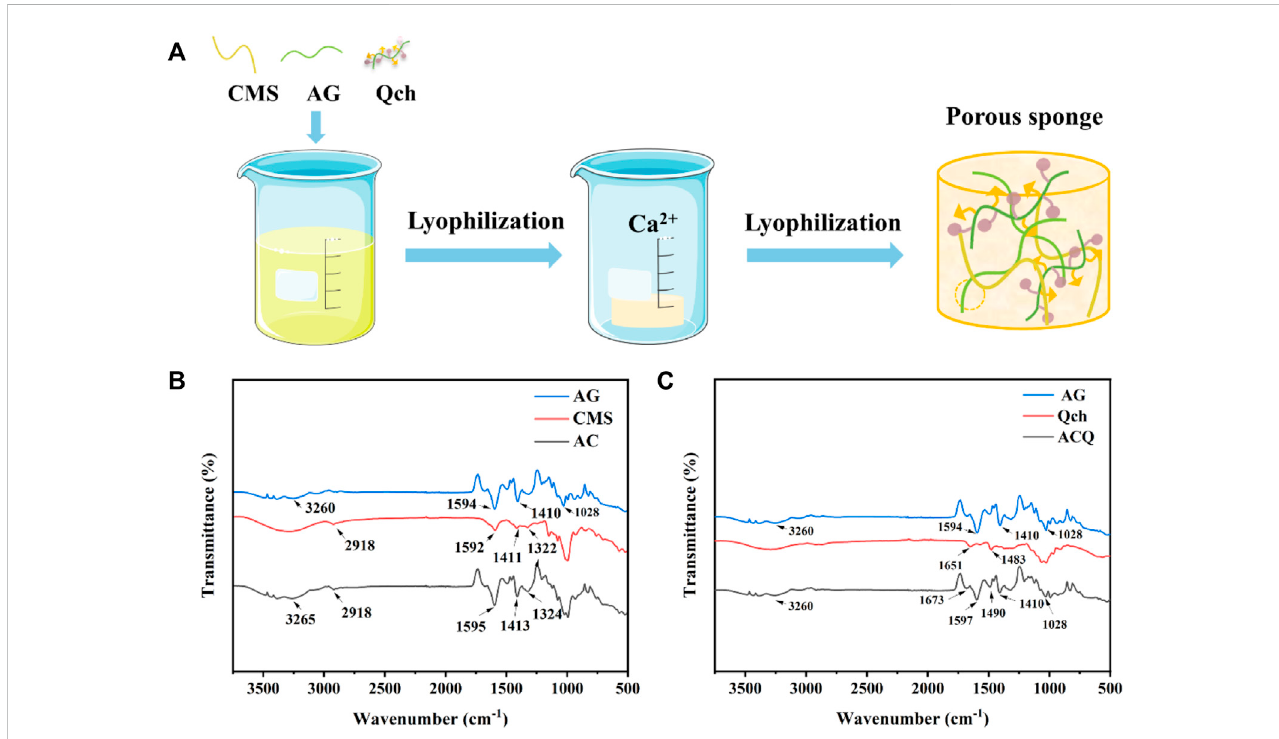
FIGURE 2 (A) Schematic diagram of the synthesis of ACQ sponges. (B) FTIR spectra of AG, CMS, and AC. (C) FTIR spectra of AG, Qch, and